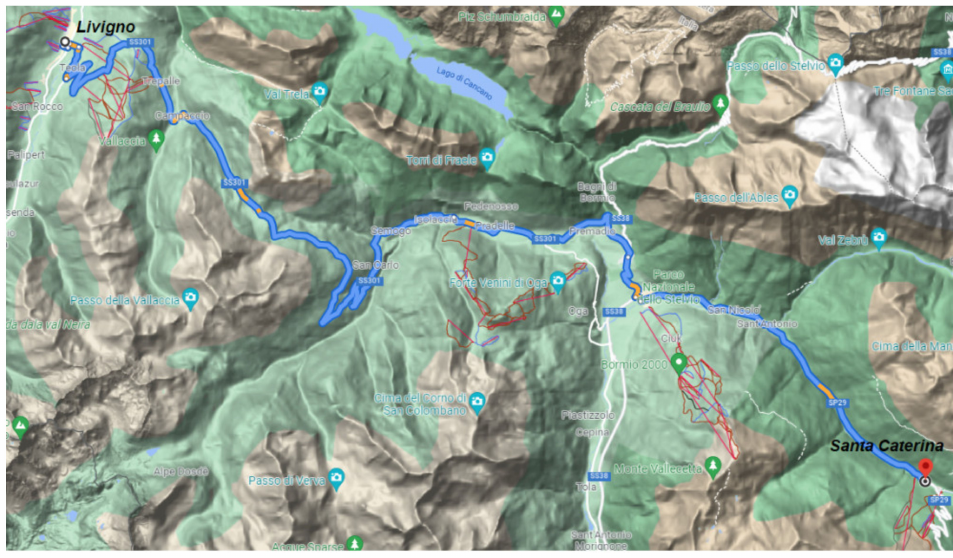
Figure 1. Highlighted